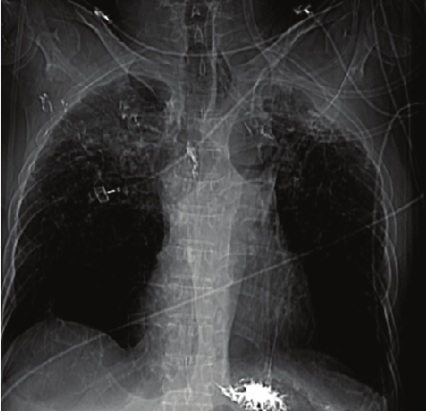
Figure 1: Chest X-ray (CXR) showed extensive fibrocalcific scarring in the upper lobes and compensatory emphysema of the lower lobes.